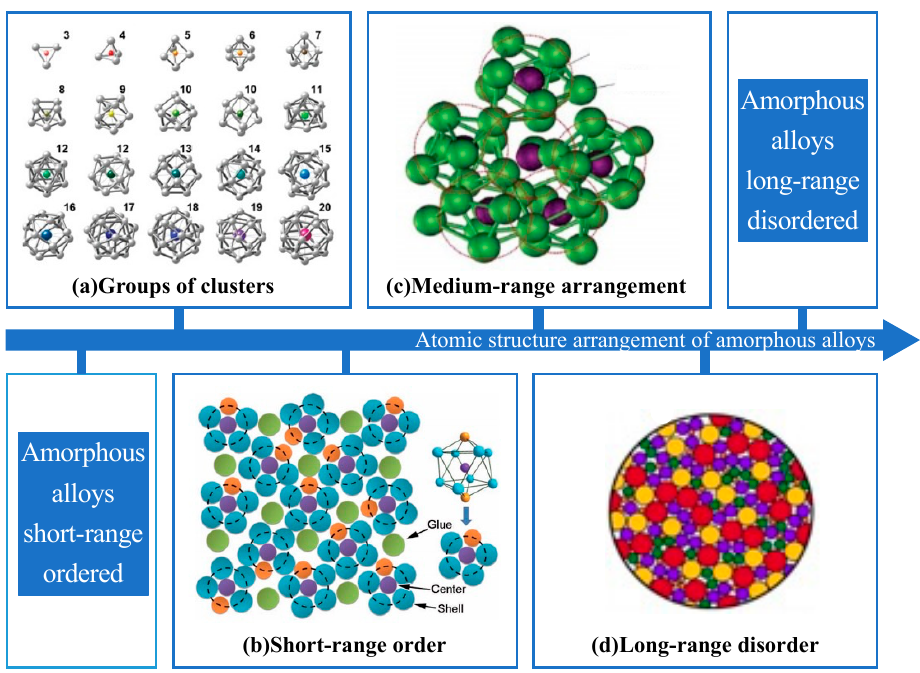
Figure 1. ( a ) The short-range atomic arrangements of amorphous alloys are composed of different kinds of clusters [3]. ( b ) The black line identifies the short-range order characteristic of amorphous alloys. ( c ) The medium-range atomic arrangement of amorphous alloys is randomly distributed by several clusters, adapted with permission from Ref. [4] 2011, Elsevier. ( d ) The long-range atomic arrangement of amorphous alloys becomes disordered.